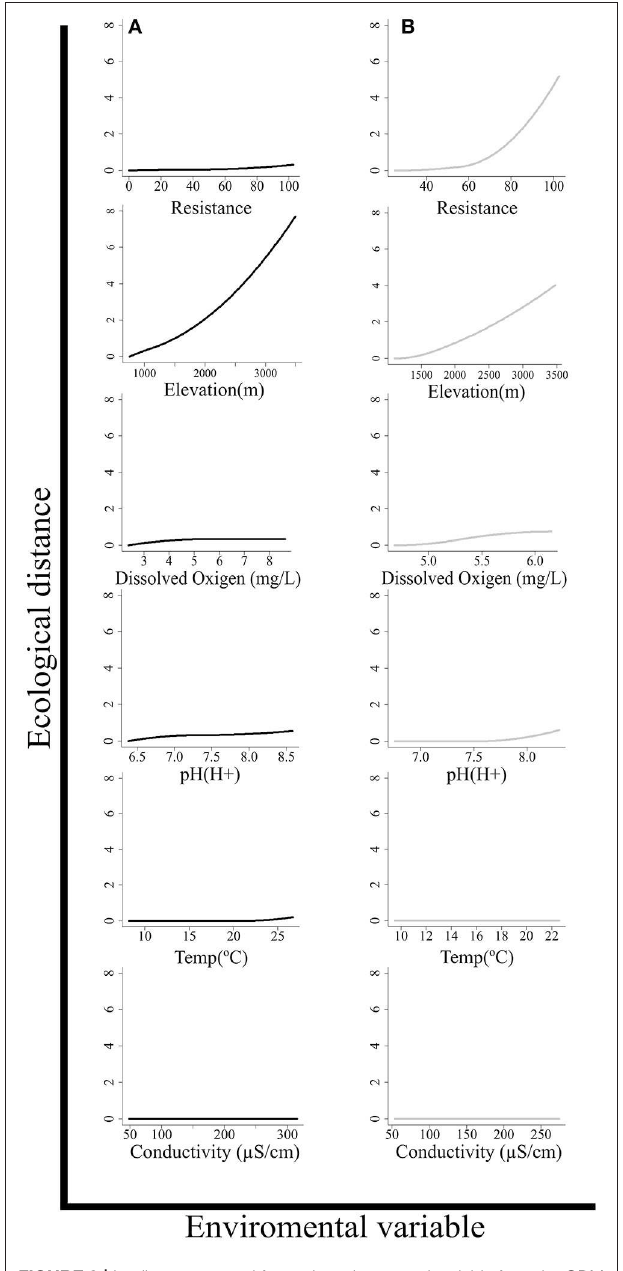
FIGURE 3 | I-splines generated for each environmental variable from the GDM model to predict beta diversity. The maximum height of each curve indicates the magnitude of turnover in fish communities with respect to that variable. The relative magnitude among variables within a model is indicative of the relative importance among variables to explain the changes in β diversity while maintaining the remaining variables constant. The form of each function indicates the rate of turnover throughout the gradient. (A) Results of model with all sampling sites (B) , and results only including only headwater stream